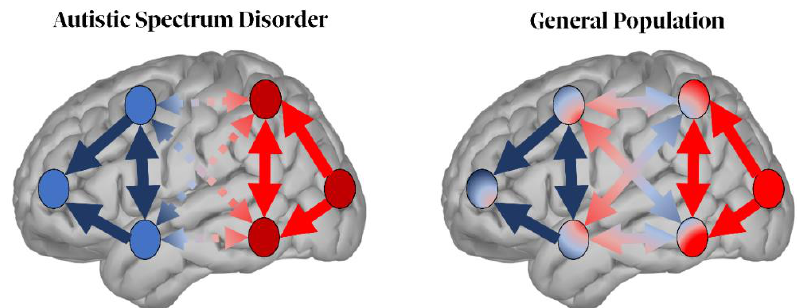
Figure 3. Imbalance in alpha connectivity in ASD relative to typically developing individuals. Persons with ASD show a local increase in connectivity in both posterior and anterior areas, while long- range connectivity between these two regions is reduced (dashed lines). Conversely, neurotypical individuals show the opposite pattern, resulting in a minor local integration (shaded circles).